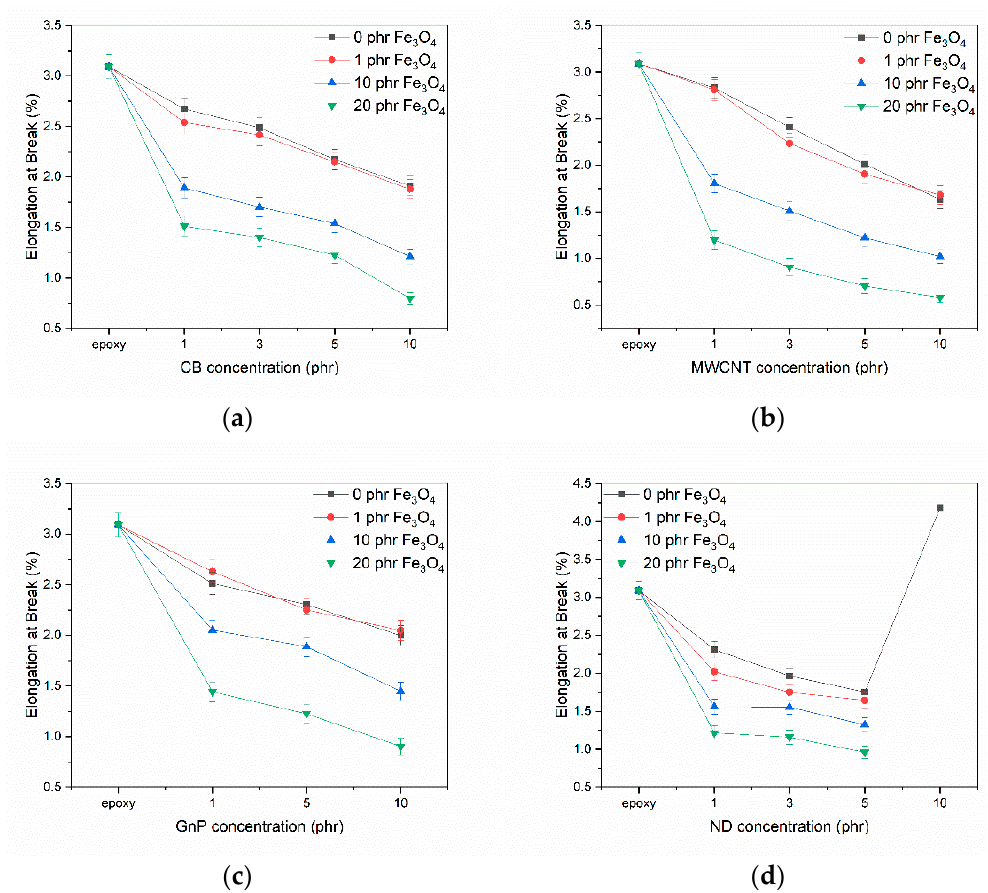
Figure 7. Elongation at break as a function of ( a ) CB; ( b ) MWCNT; ( c ) GnP; ( d ) ND concentration for all examined systems.